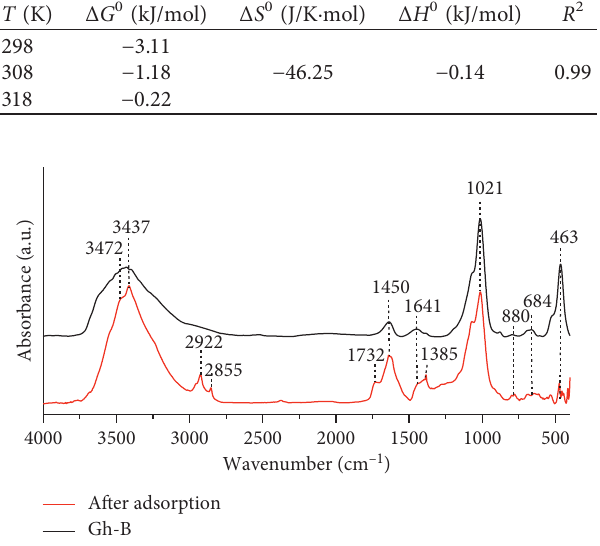
Figure 12: FTIR spectra of Gh-B before and after